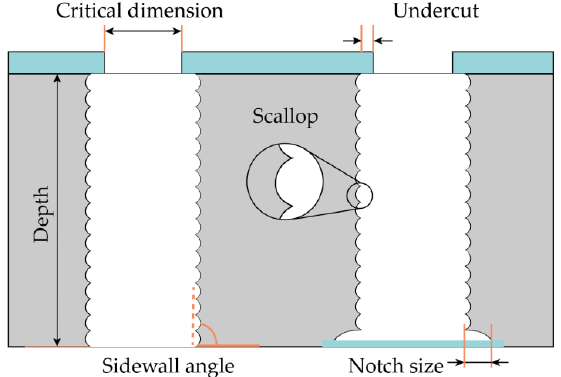
Figure 1. Schematic view of cross-section profile after the Bosch process silicon etching.